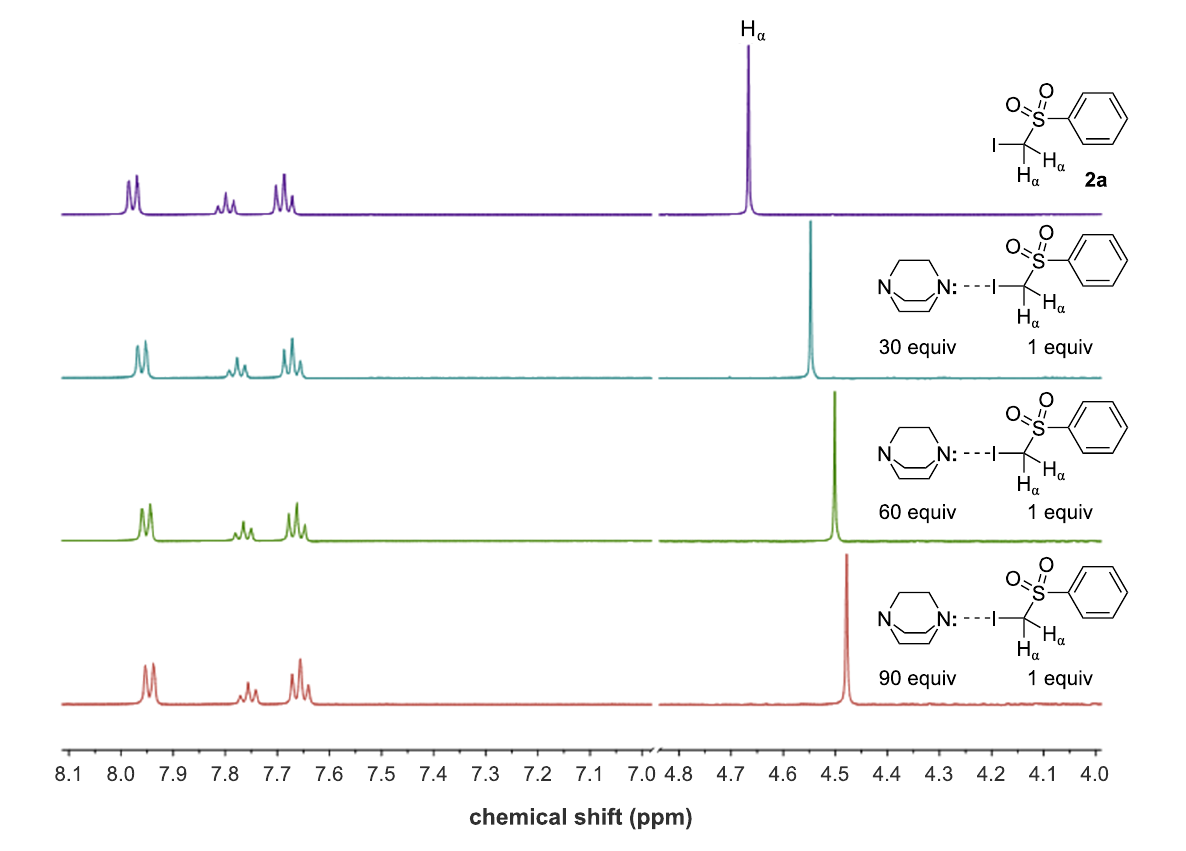
Figure 3: 1 H NMR titration of DABCO in a solution of 2a in ACN- d 3 to detect their halogen-bonding association through the shift of the signal of H α .